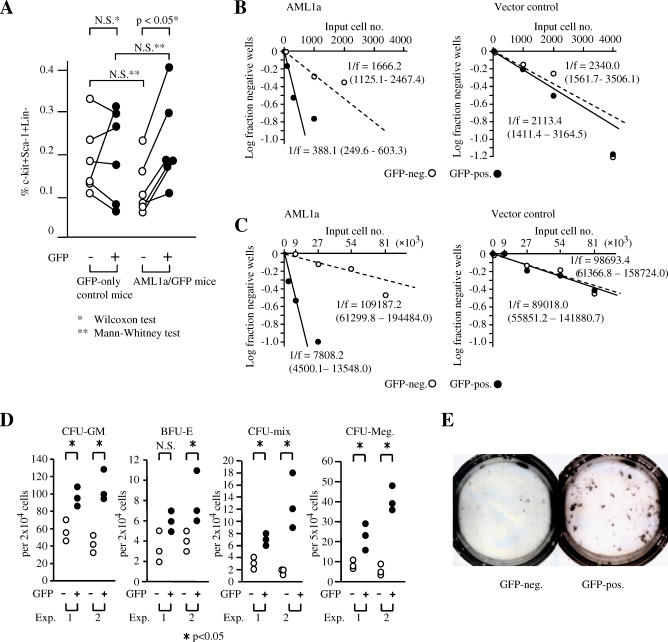
Analysis of BM Compartments in Engrafted AnimalsResults from GFP+ and GFP− cells are shown in solid and open symbols, respectively.(A) Percentages of KSL cells in GFP+ and GFP− fraction of individual animals are presented pairwise. All animals were analysed 4 mo after transplantation. Statistical significance was evaluated using Wilcoxon and Mann-Whitney tests.(B) LTC-IC analysis of GFP+ and GFP− cells from the lin− BM compartment of AML1a and control animals. LTC-IC frequency within the lin− compartment and its 95% confidence interval (in parenthesis) are presented. Two independent experiments gave a similar result.(C) CAFC analysis of GFP+ and GFP− cells from total BM of AML1a and control animals. Wells containing clusters of six or more cobblestone cells after 35 d of culture were scored as positive, and the frequency of CAFC calculated by Poisson statistics; CAFC frequency and its 95% confidence interval (in parenthesis) are presented. Two independent experiments gave a similar result.(D) Colony-forming activity BM cells sorted from an AML1a animal and cultured under multimyeloid (CFU-GM, erythropoietic burst formation [BFU-E], and CFU-mix) and megakaryocytic (CFU-meg) conditions are shown. Representative data from three independent experiments conducted in triplicate are presented. Asterisks indicate statistical significance of the difference estimated by Mann-Whitney test.(E) Photomicrographs show relative sizes of colonies generated in multimyeloid condition.